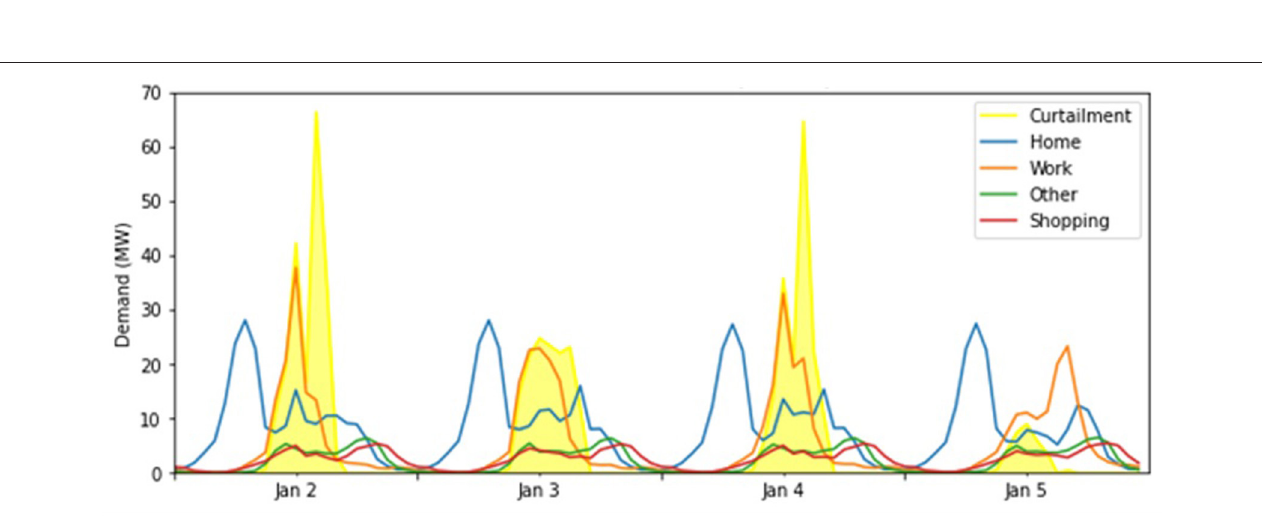
FIGURE 12 | Time-shifting of EV demand load due to curtailment within Scenario 3B disaggregated by trip activity for select dates with low curtailment in the winter.